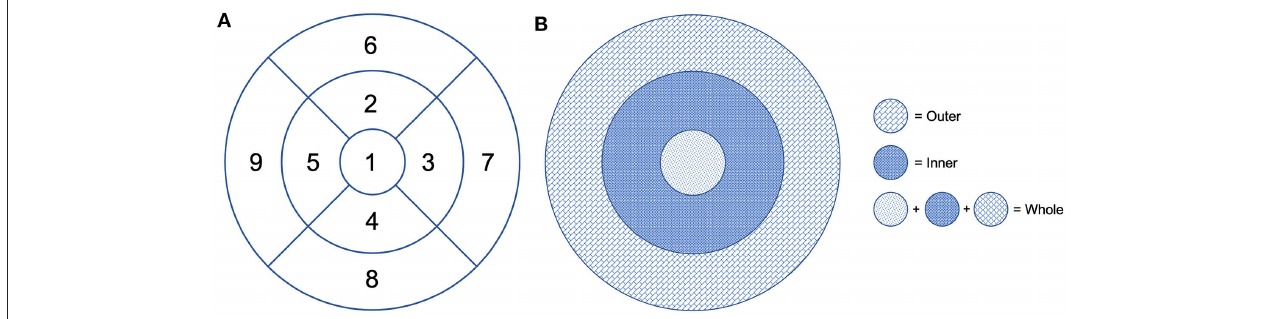
FIGURE 2 | Early Treatment Diabetic Retinopathy (ETDRS) grid centered on the fovea. (A) Division of the macular area into nine subfields: 1 = center, 2 = inner superior, 3 = inner right, 4 = inner inferior, 5 = inner left, 6 = outer superior, 7 = outer right, 8 = outer inferior, and 9 = outer left. (B) The fovea is defined as the area within the central 1-mm ring of the ETDRS grid. The surrounding ring with an inner diameter of 1mm and an outer diameter of 3mm is considered as the inner ring. The ring with an inner diameter of 3mm and an outer diameter of 6mm is considered as the outer ring. The whole includes the fovea and the inner and outer rings.